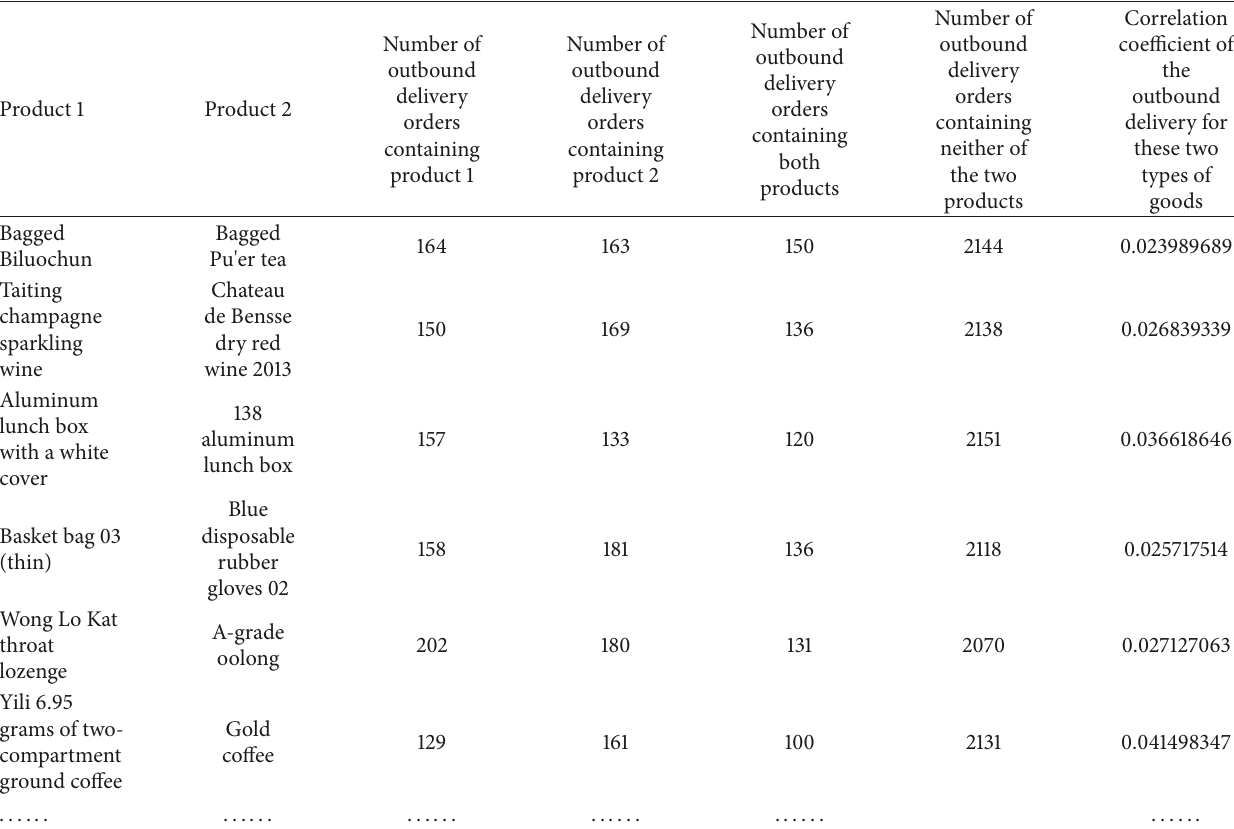
Table 4: Outbound correlation data of some high-frequency picked outbound